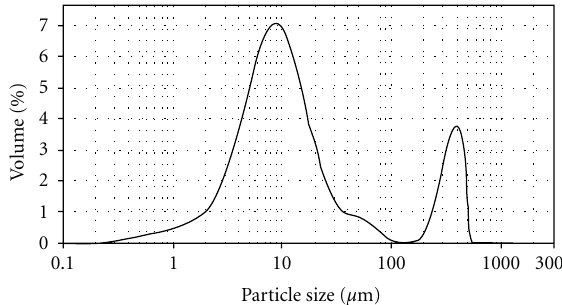
Figure 1: Particle size distribution of HA.